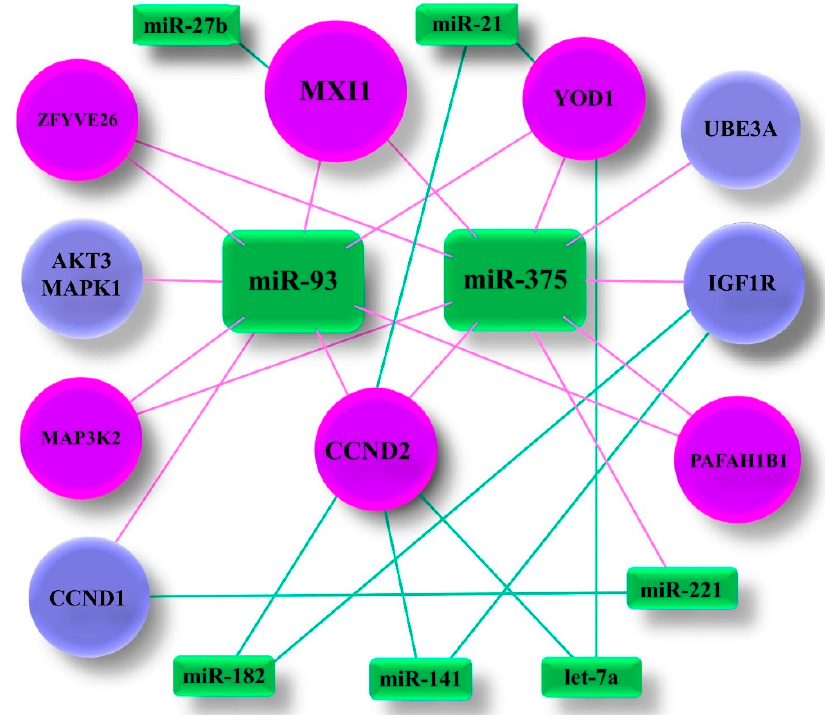
Figure 5. miRNA target gene correlations; MAPK1 (Mitogen-activated protein kinase 1), UBE3A (Ubiquitin protein ligase E3A), CCND1 (Cyclin D1), IGF1R (Insulin like growth factor 1 receptor), AKT3 (AKT serine/threonine kinase 3).